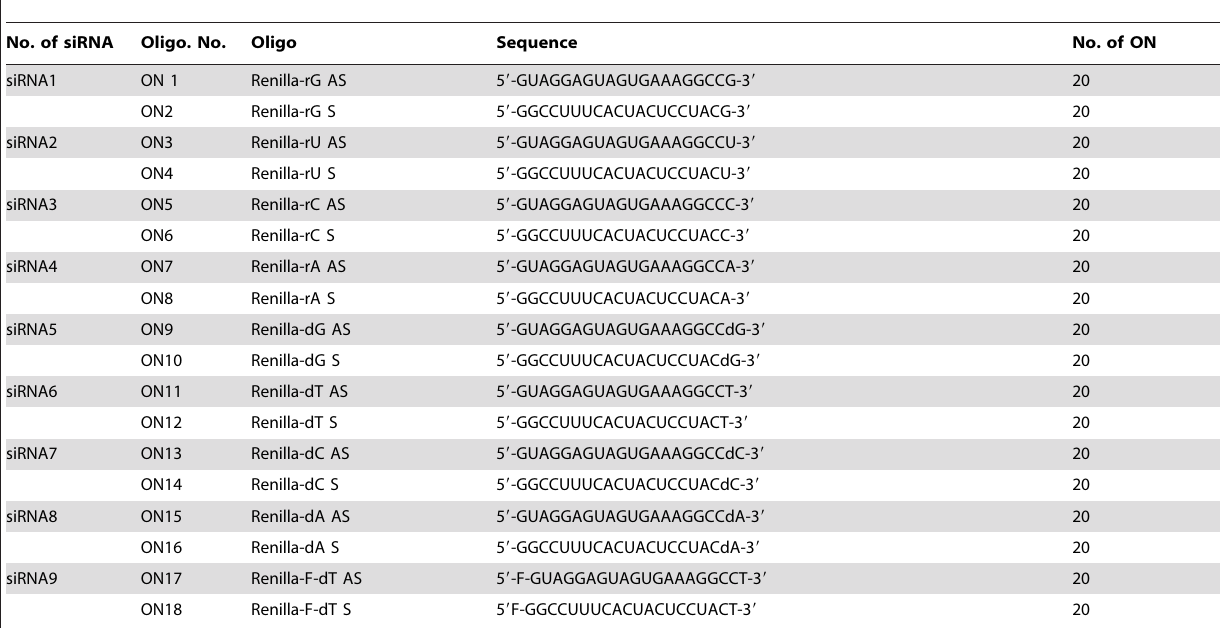
Table 1. Sequence of oligonucleotides used in this